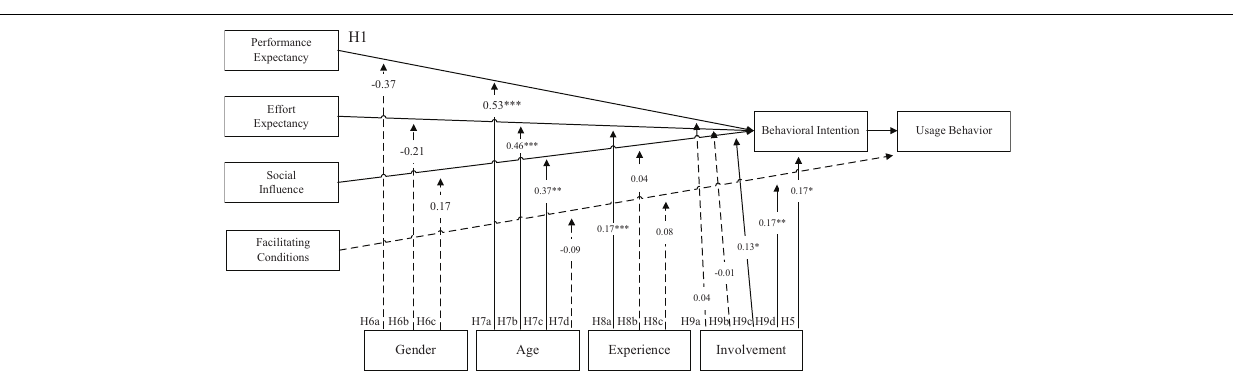
FIGURE 3 | Moderation effects of UTAUT. * p < 0.05; ** p < 0.01; *** p <